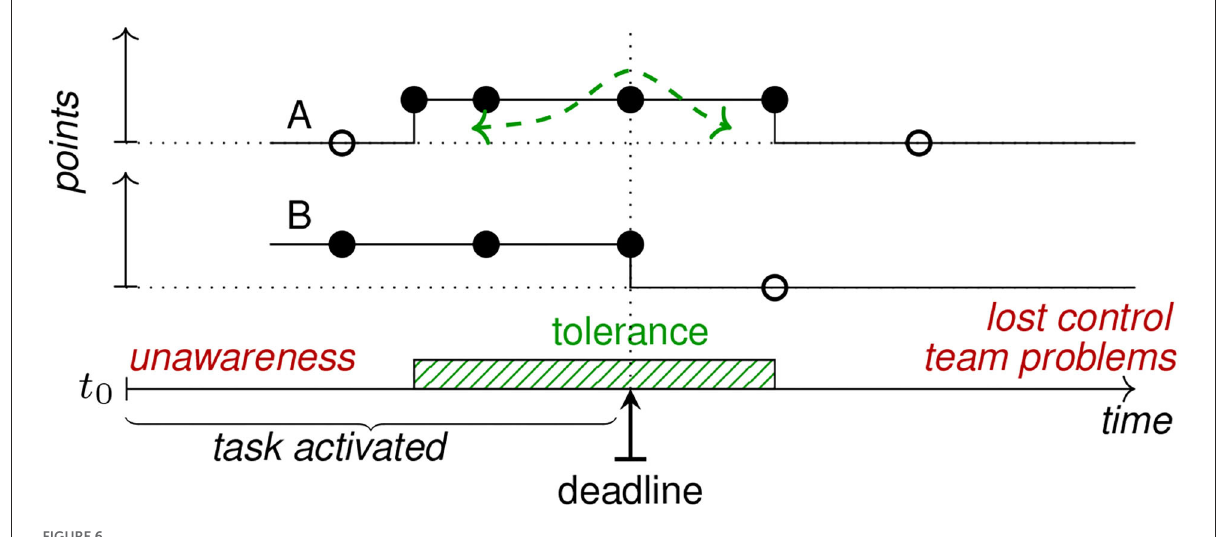
FIGURE6 Task scoring along the time